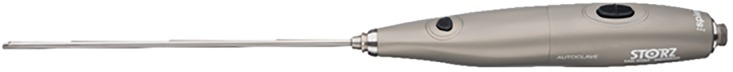
Image of the digiCAMeleon.